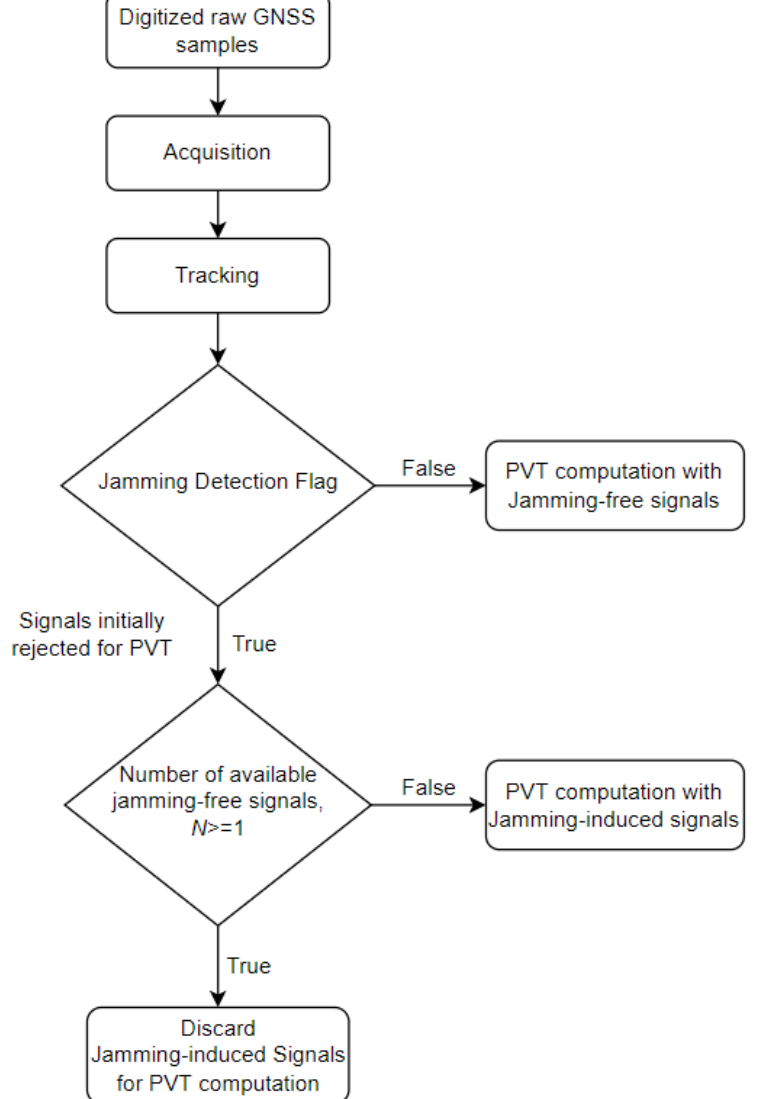
Figure 5. Concept illustration of a resilient MFMC receiver.